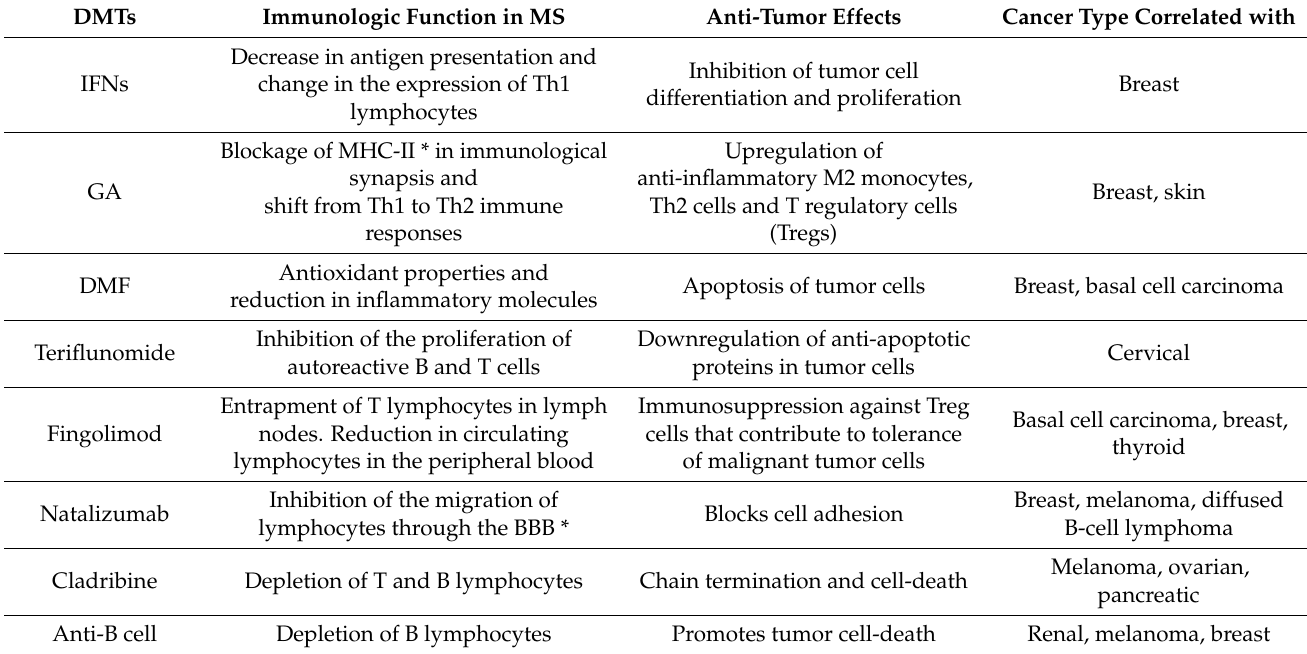
Table 4. DMTs function in MS and correlation with